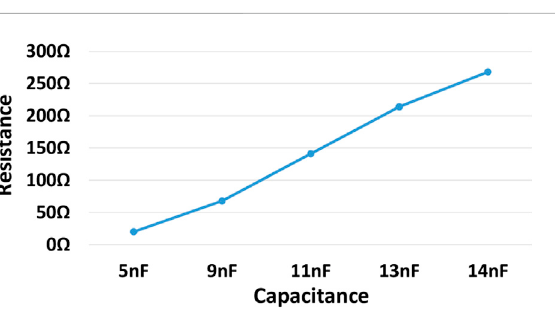
FIGURE 18 The curve of the maximum value of the load resistor, after fi ve groups of auxiliary capacitors are connected in parallel.